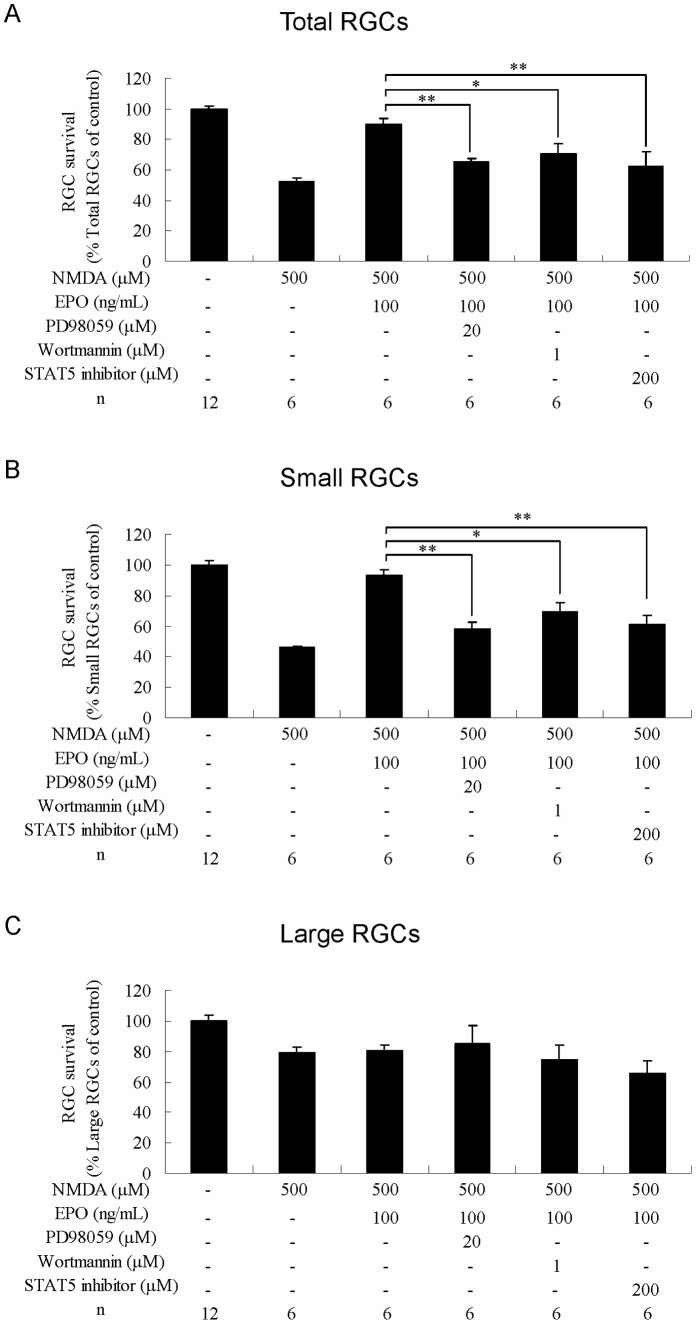
Effects of combined treatment with erythropoietin and kinase inhibitors on RGCs under NMDA-induced toxicity. Survival rates of (A) total, (B) small, and (C) large RGCs were estimated as percentages of the control. Data are presented as mean ± standard error of the mean (n = 6–12). Data were statistically analyzed by 1-way ANOVA, followed by Dunnett’s test. *P<0.05, **P<0.01 and ***P<0.001.